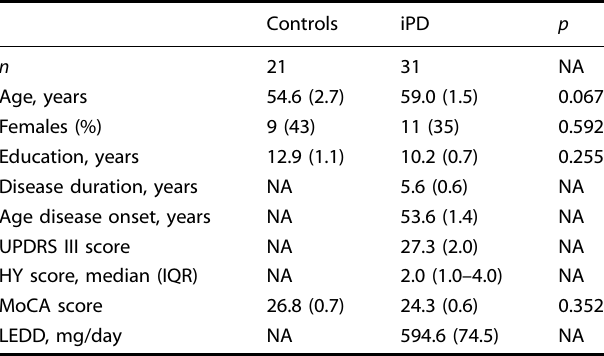
Table 1. Demographics and neurological characteristics of